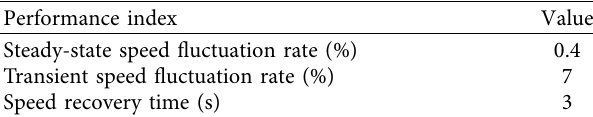
Table 2: Performance indexes of the secondary power station.